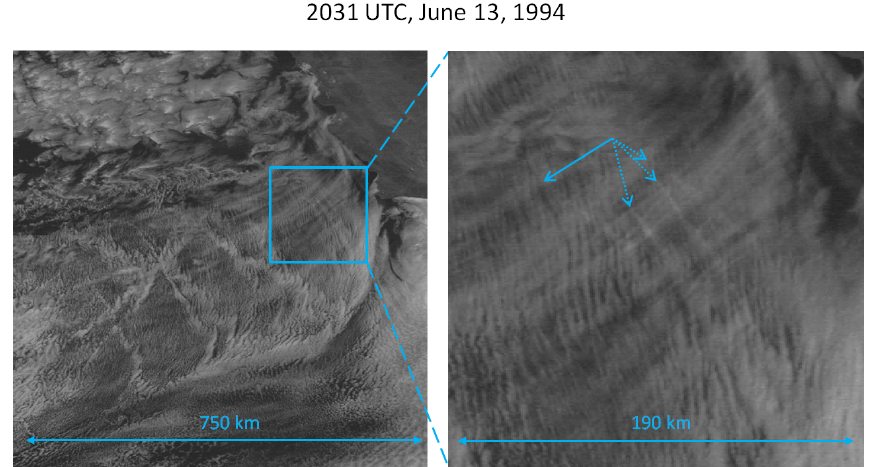
Figure 1. GOES satellite imagery of the eastern Pacific near California at 20:13UTC on 13 July 1994. A number of ship tracks are clearly visible well off shore. The right panel gives an enlarged view of clouds to the southwest of Monterey; despite cirrus obscuring the view, several tracks are apparent, indicated with arrows. The solid arrow marks the estimated location of the Sanko Peace at the time of the